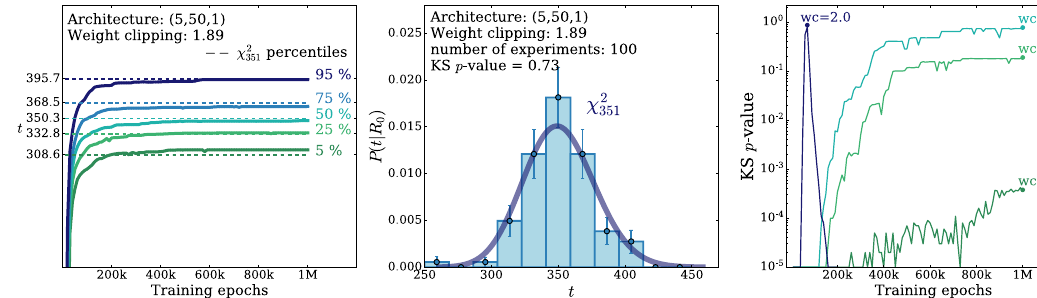
Fig. 10 Same as Fig. 9, but for the ( 5 , 50 , 1 ) architecture